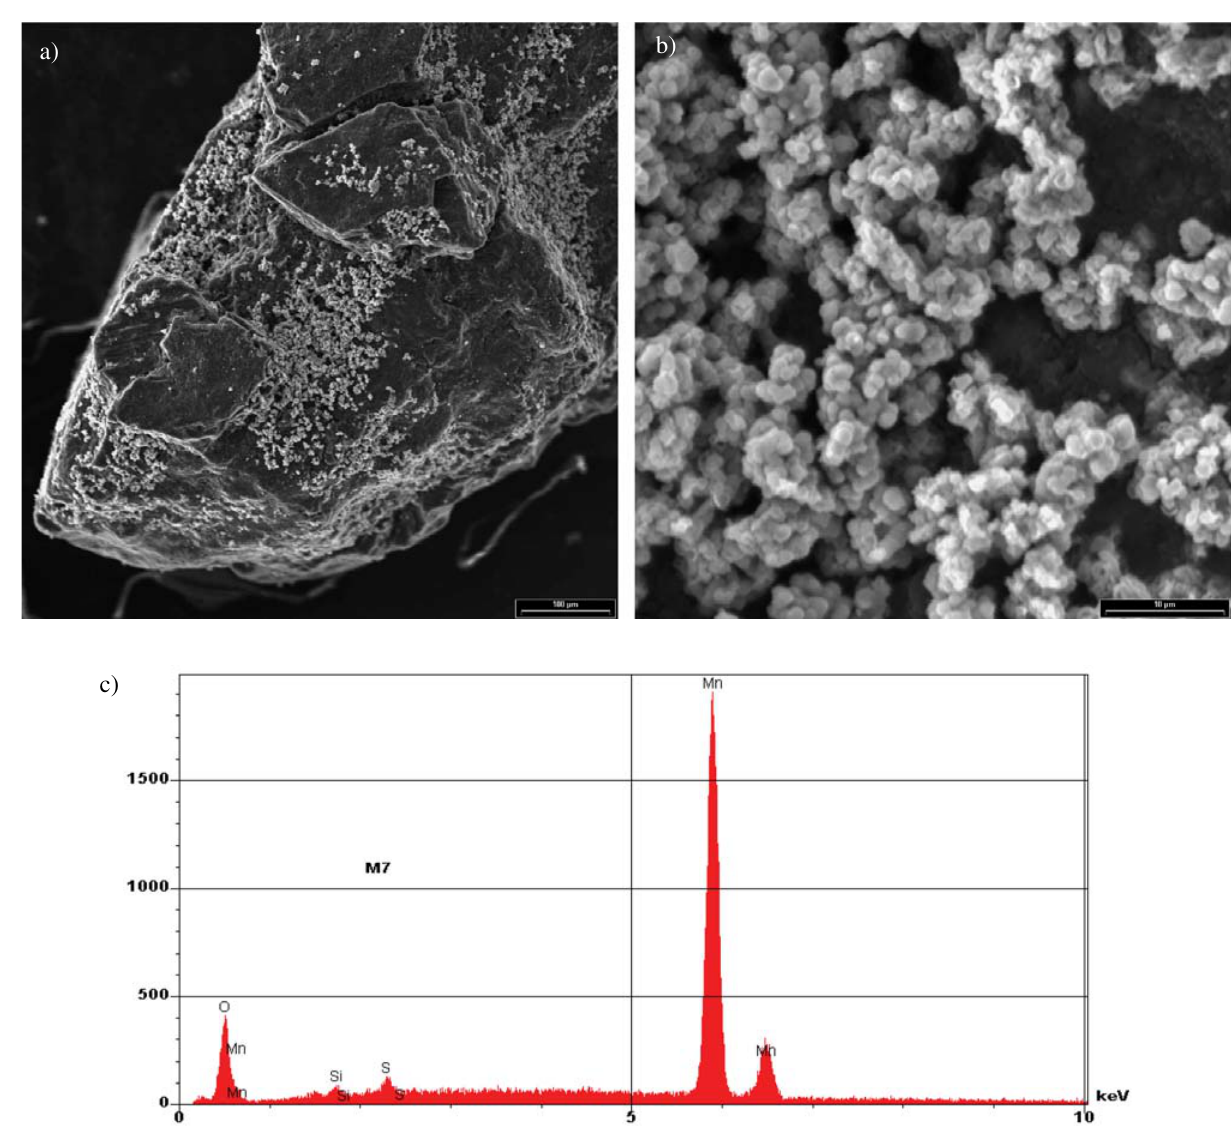
Figure 2. Typical micrographies of the synthetized materials. (a) 150×, (b) 2000×, (c) EDS obtained in